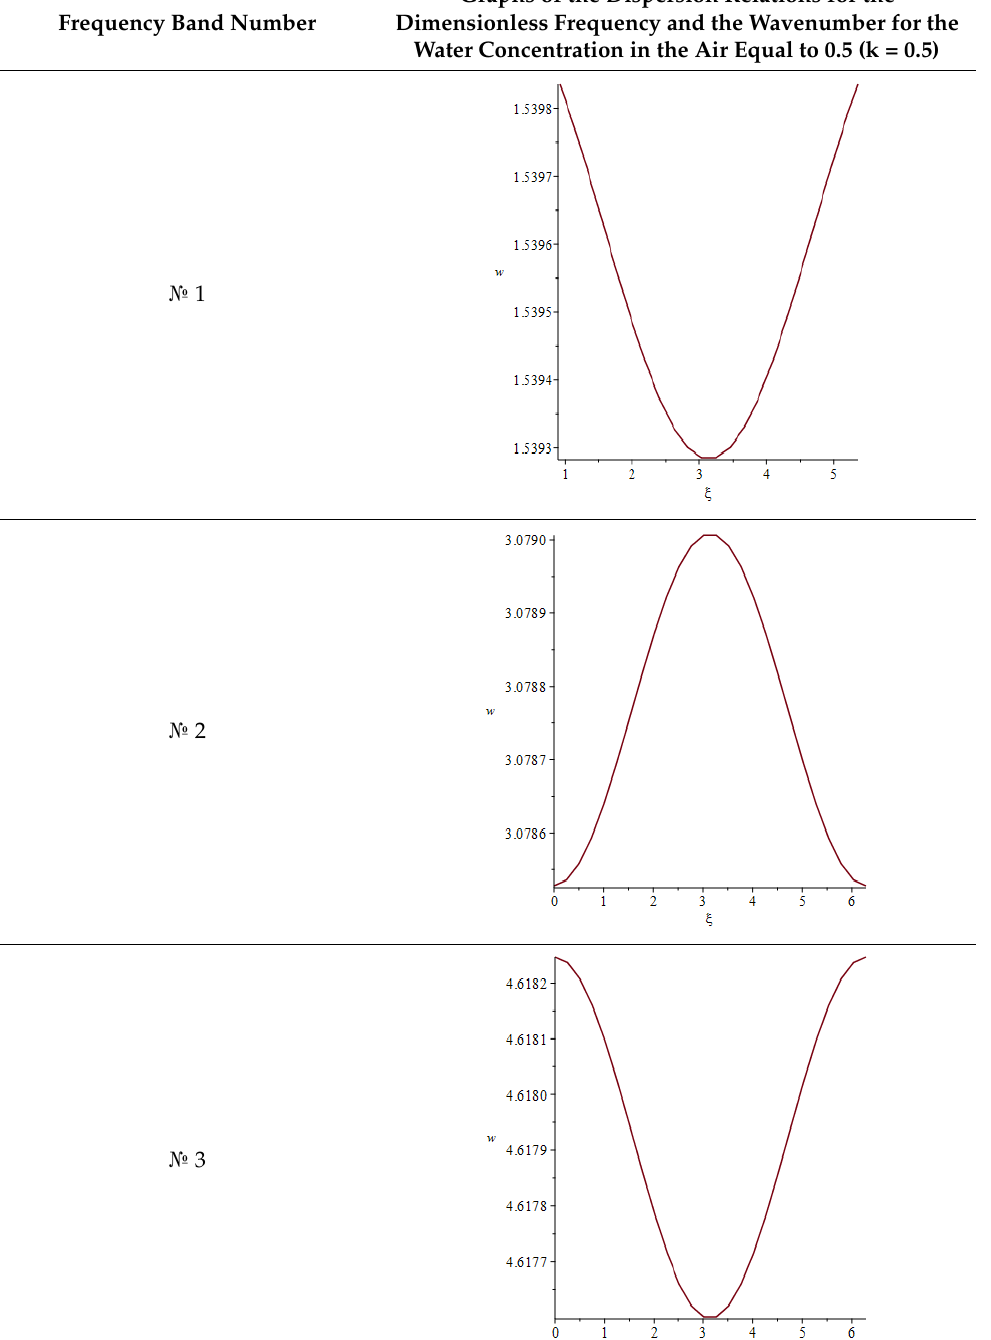
Table 3. Cont. Graphs of the Dispersion Relations for the Frequency Band Number Dimensionless Frequency and the Wavenumber for the Water Concentration in the Air Equal to 0.5 (k = 0.5)